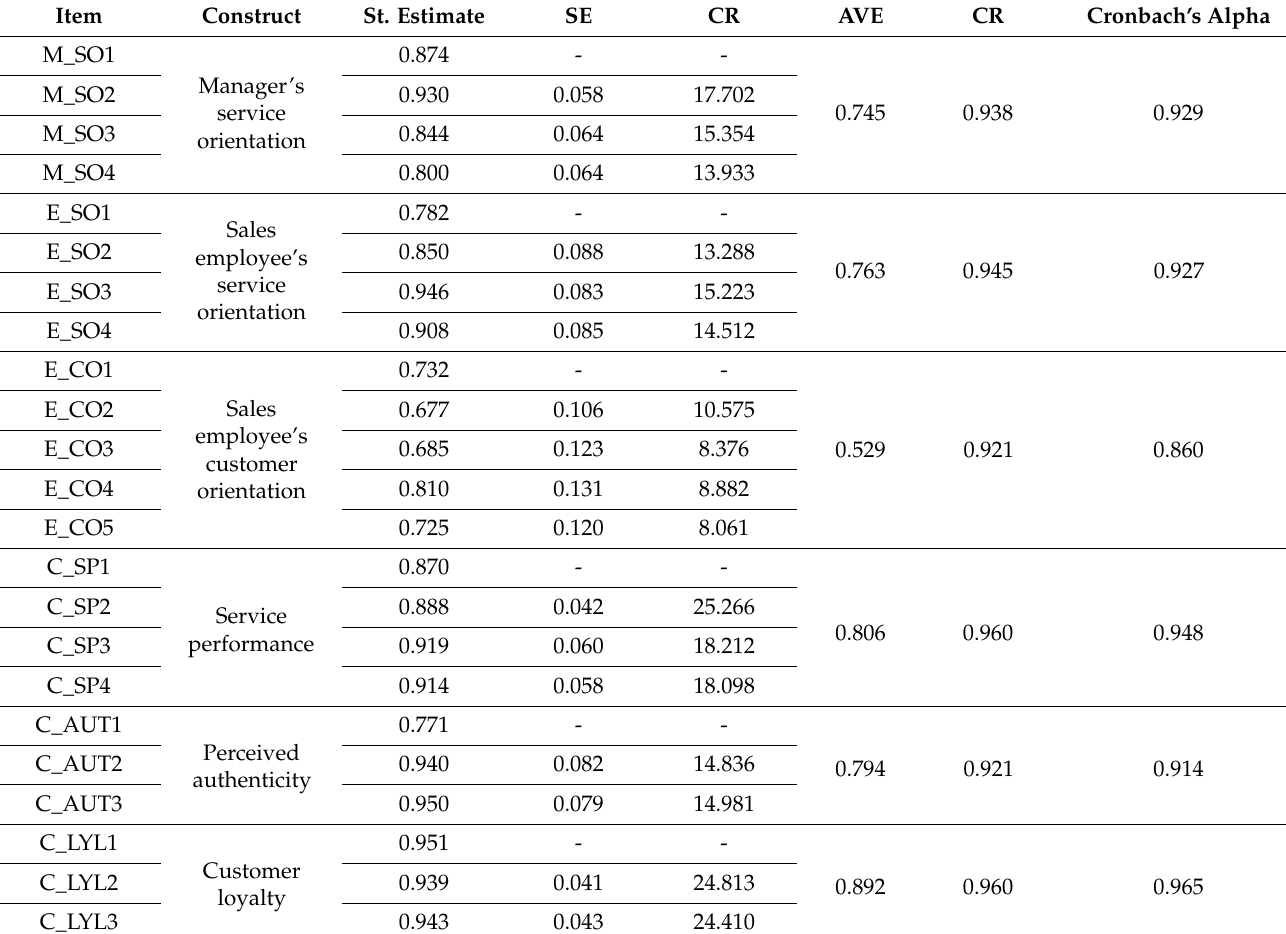
Table 2. Results of the reliability and validity